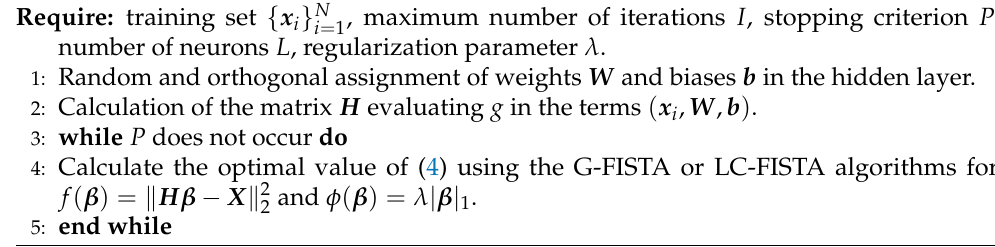
Algorithm 1 Training of the ELM-AE with FISTA, G-FISTA, and